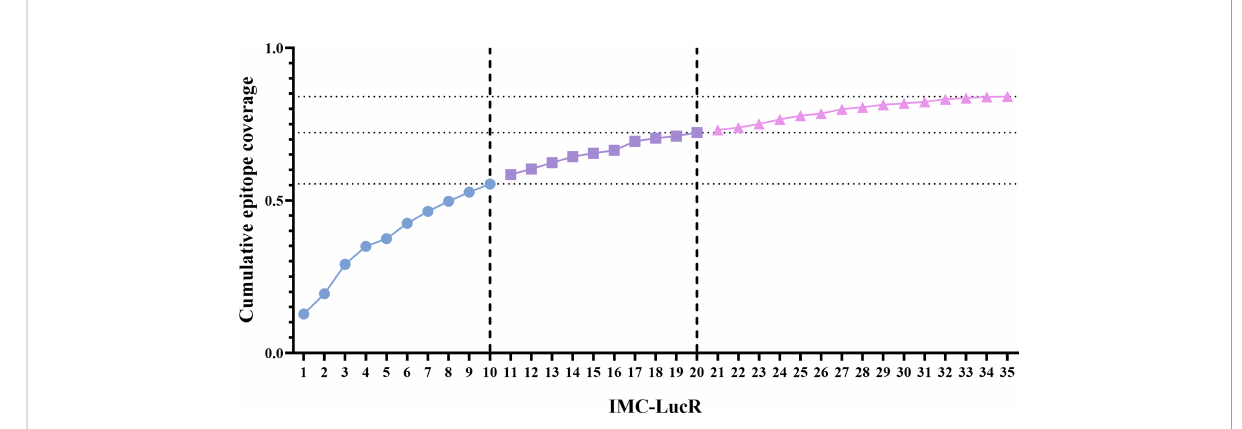
FIGURE 5 Coverage distribution plot for 35 full length HIV-1 Transmitted/founder proteome sequences, representing the cumulative epitope coverage provided against a larger proteome cohort (N=218). Dotted lines re fl ect cumulative predictive epitope coverage for each potential panel (identi fi ed through dashed lines).